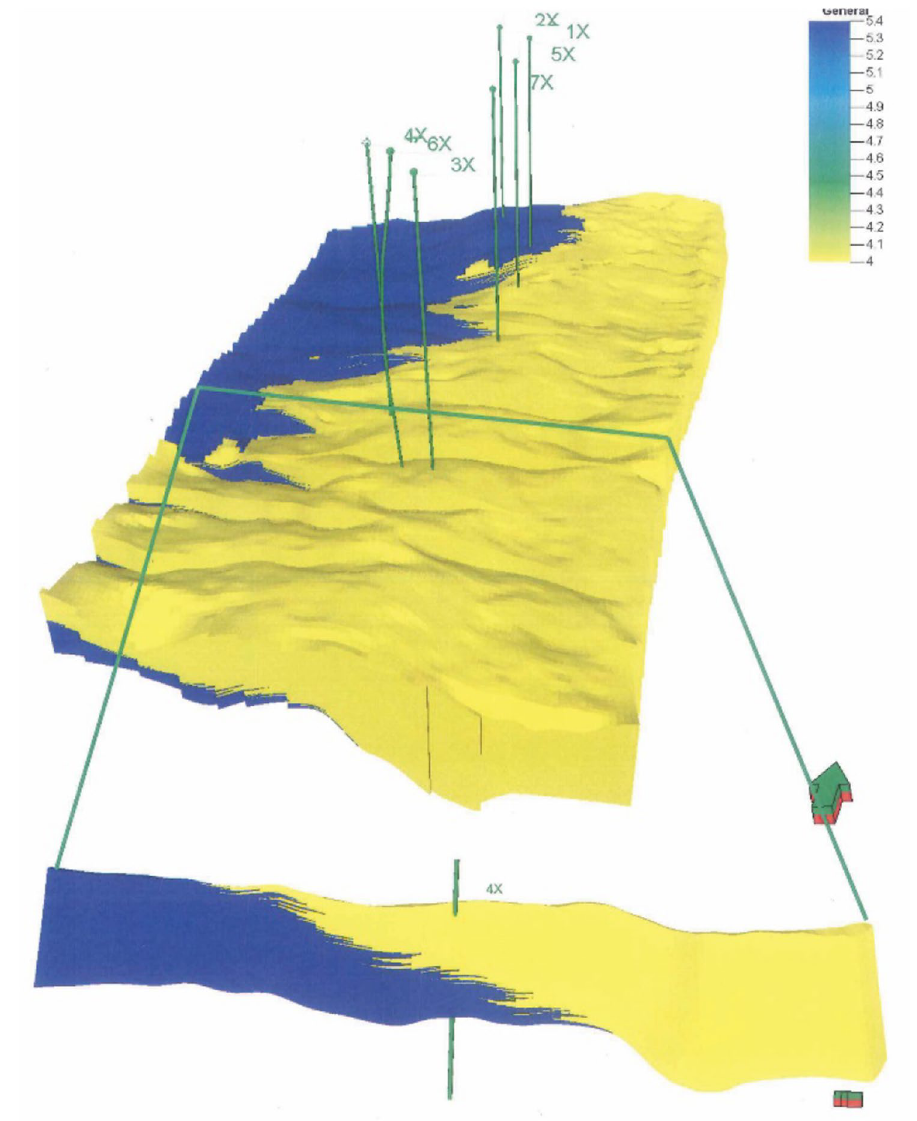
Fig. 23 Model in